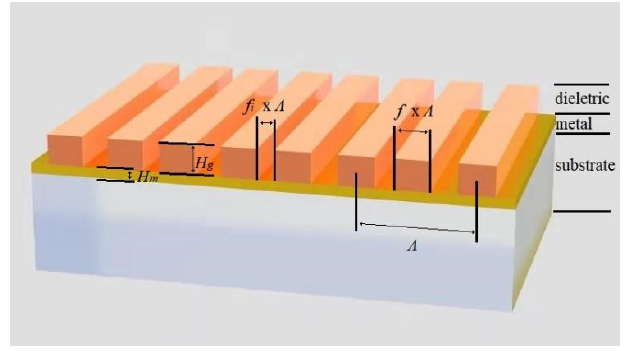
Figure 1. Configuration of MADG structure.